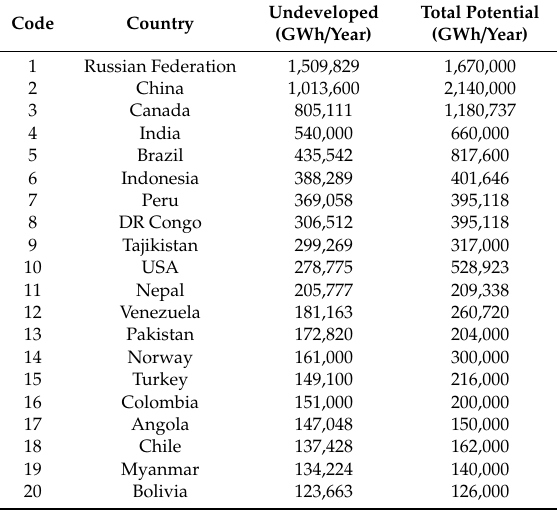
Table A2. Top 20 countries by unutilized hydropower